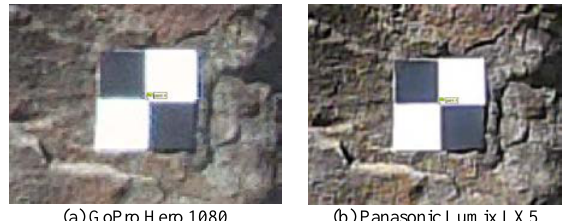
Figure 3. Close-up view of one of the target used for scale and georeferencing